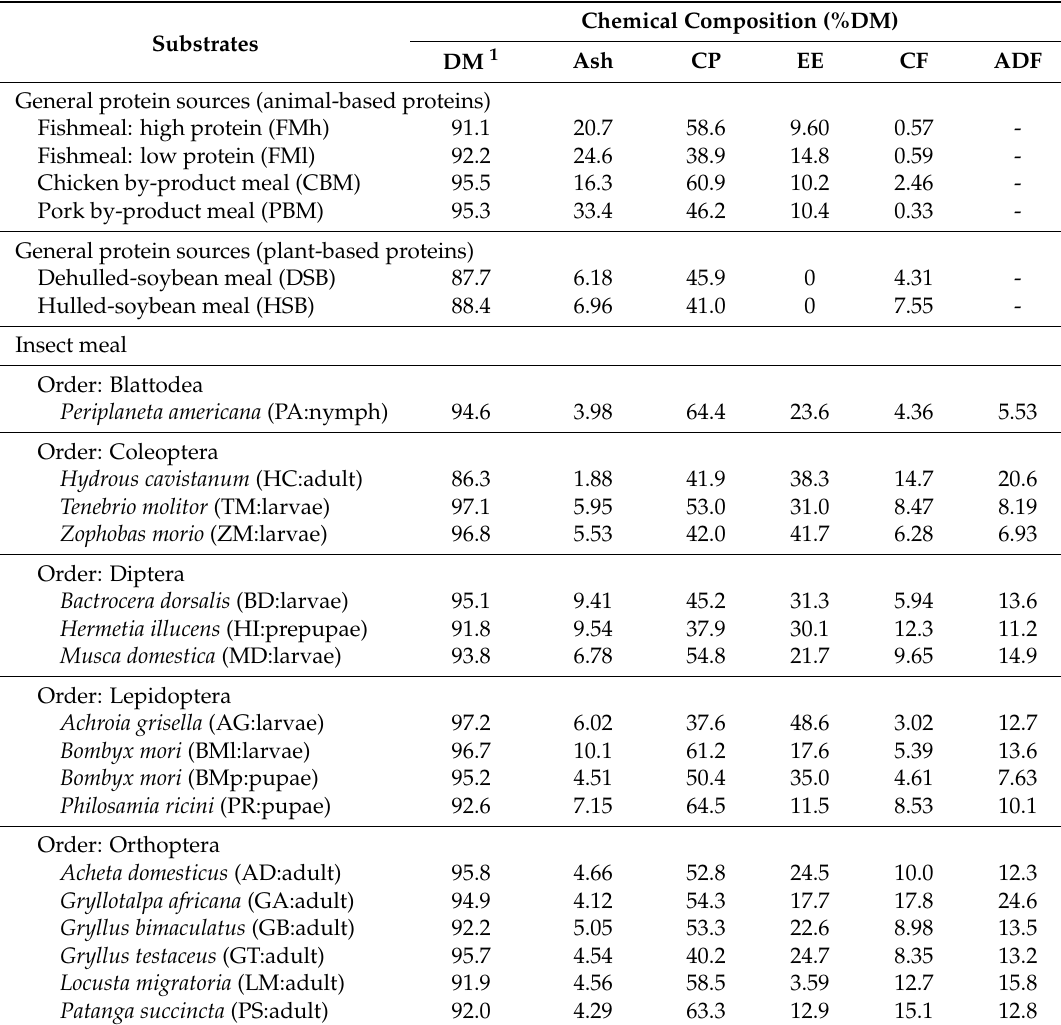
Table 1. Chemical composition of general protein sources and insect